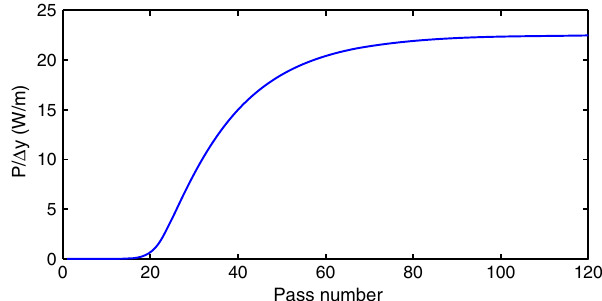
FIG. 6. Plot of power per unit beam width in the surface mode as a function of number of